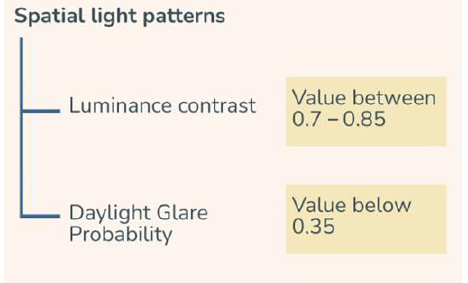
Figure 4. Spatial light patterns and requirements.